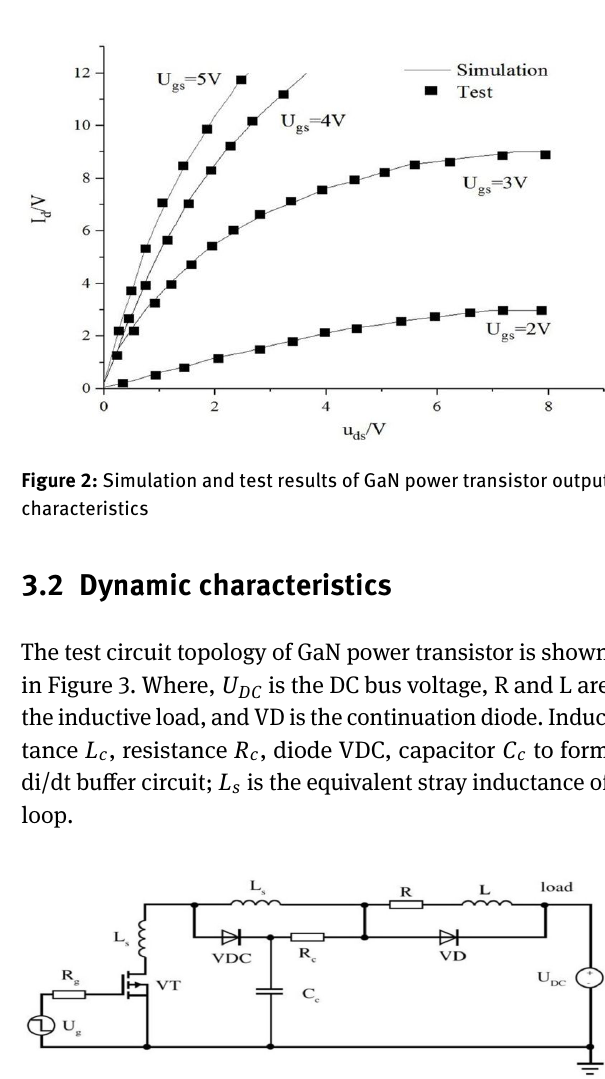
Figure 3: GaN power transistor test circuit topology